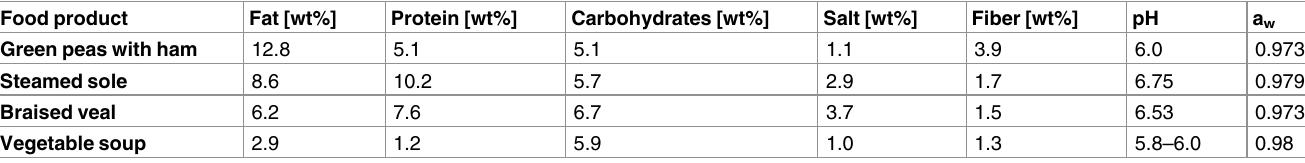
Table 1. Food product